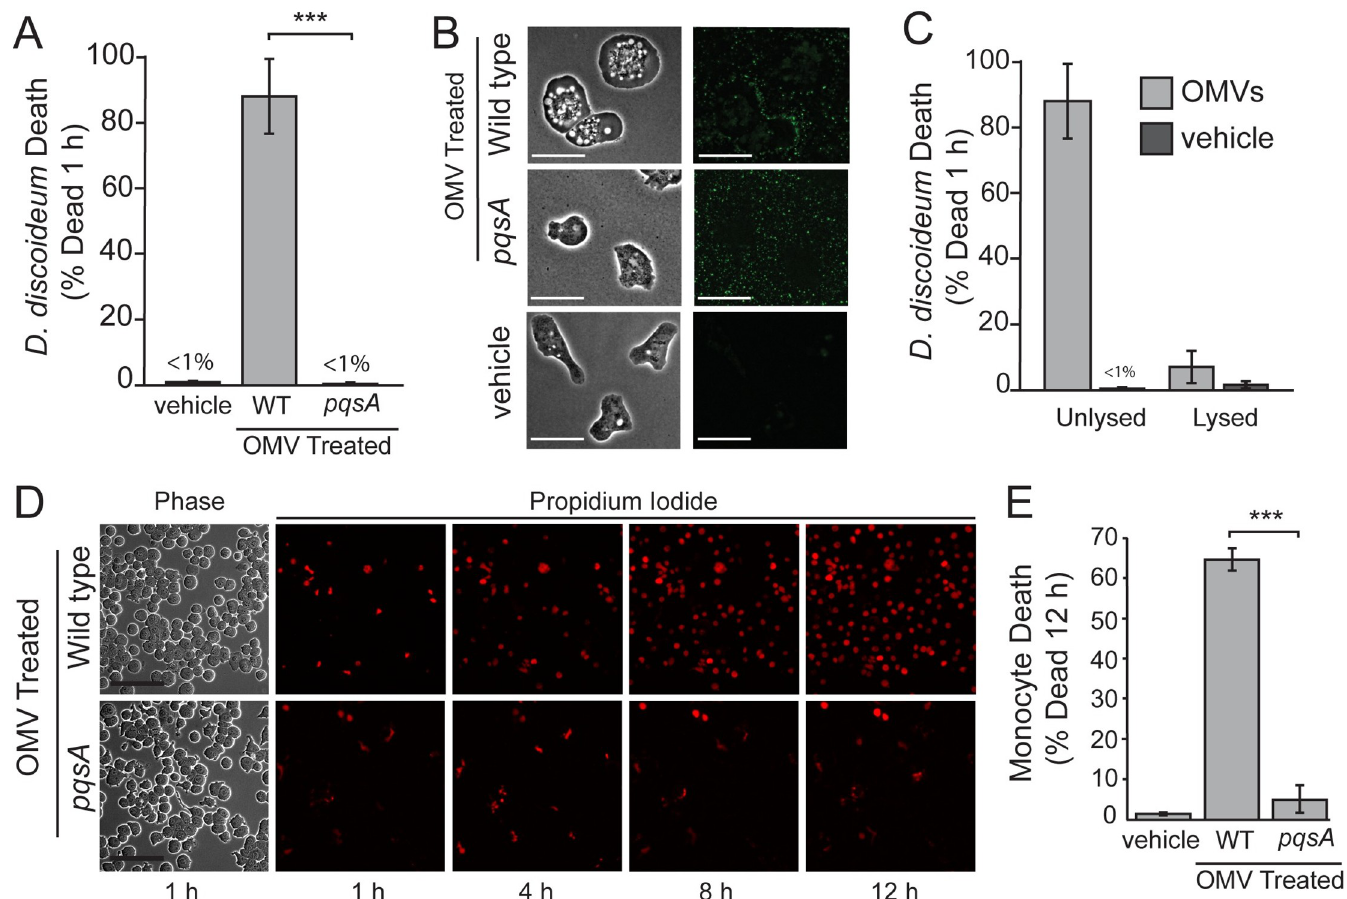
Fig 3. AQs are responsible for OMV cytotoxicity and OMV packaging enhances AQ potency. (A) Quantification of D . discoideum death following treatment of axenic cultures with outer membrane vesicles (OMVs) isolated from wild type (WT) and Δ pqsA mutant P . aeruginosa or a vehicle control (t = 1 h). (B) Images of D . discoideum treated with fluorescently labelled OMVs ( oprM :: mNeonGreen ) from wild type and pqsA backgrounds in the absence of live-dead calcein-AM dye after 1 h (scales bars = 10 μ m). (C) Quantification of D . discoideum death following treatment of axenic cultures with lysed or unlysed outer membrane vesicles (OMVs) isolated from wild type (WT) P . aeruginosa (t = 1 h). (D) Representative images of TIB-67 mouse monocyte at various timepoints following treatment with OMVs isolated from wild type (WT) and pqsA mutant P . aeruginosa or a vehicle control. Propidium iodide (red) staining of nuclei indicates cell death (scale bars = 100 μ m). (E) Quantification of monocyte death in (D). Percent death is the increase in PI-stained nuclei divided by the total PI-negative cells at 1 h. Values are mean +/- SEM. Approximately 2500–3000 cells were analyzed for each measurement. Data shown in (B) and (C) are mean and SD of two independent experiments. Approximately 300–500 cells were analyzed for each condition. Vehicle control is solution collected by filtering OMV samples in PBS (pH = 7) through 100k MWCO filters. Statistical analysis in B and E is Student’s two-tailed t-test ( ��� = p <